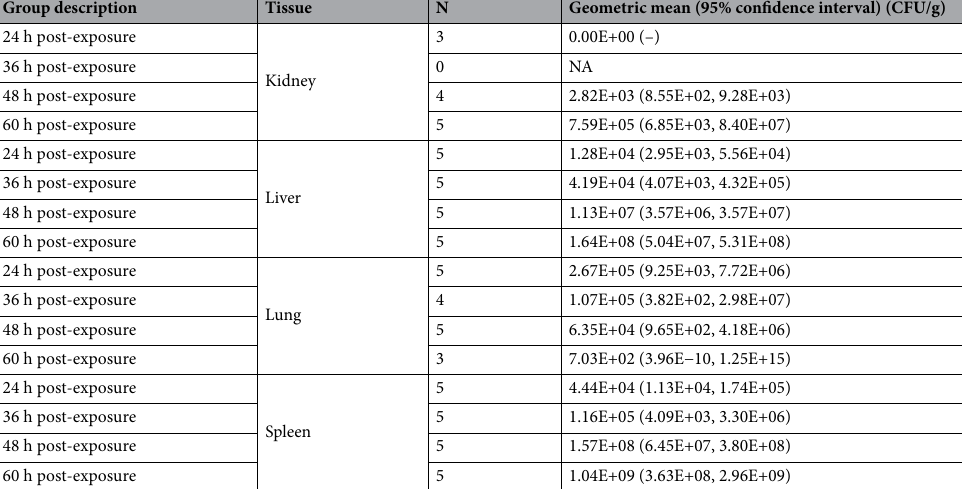
Group description Tissue N Geometric mean (95% confidence interval)